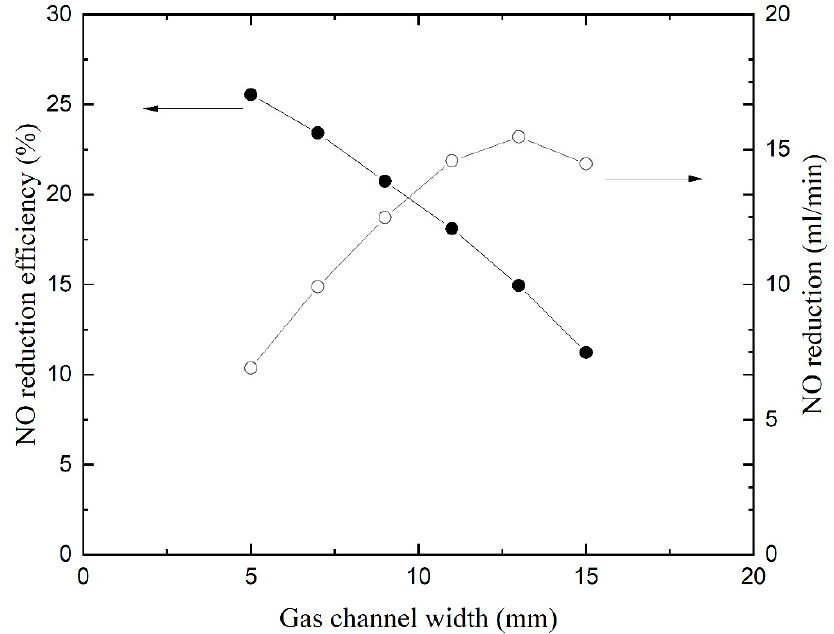
Figure 9. NO reduction and efficiency as a function of gas channel width.